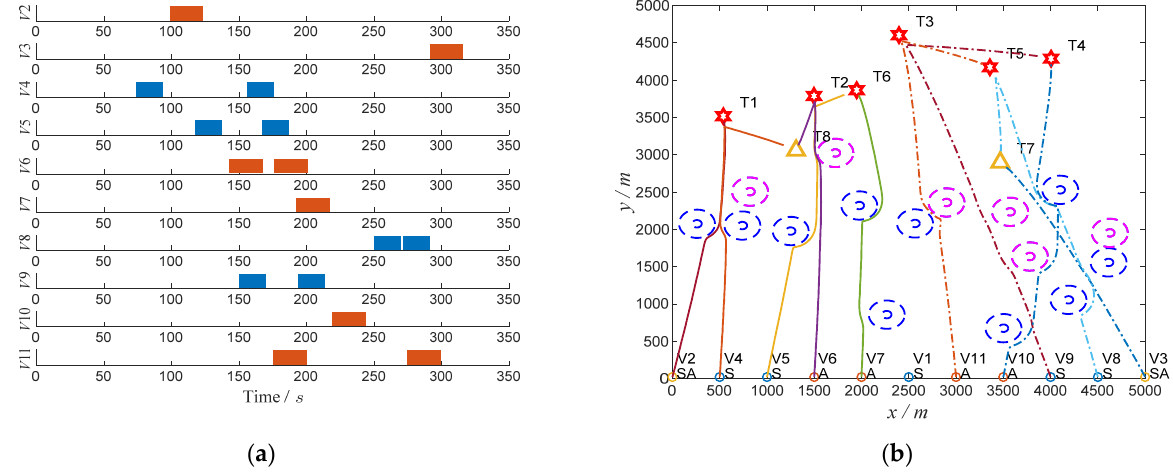
Figure 13. ( a ) The execution sequence of the UAV swarm; ( b ) the diagram of the UAV swarm performing tasks. (Considering unknowned targets)